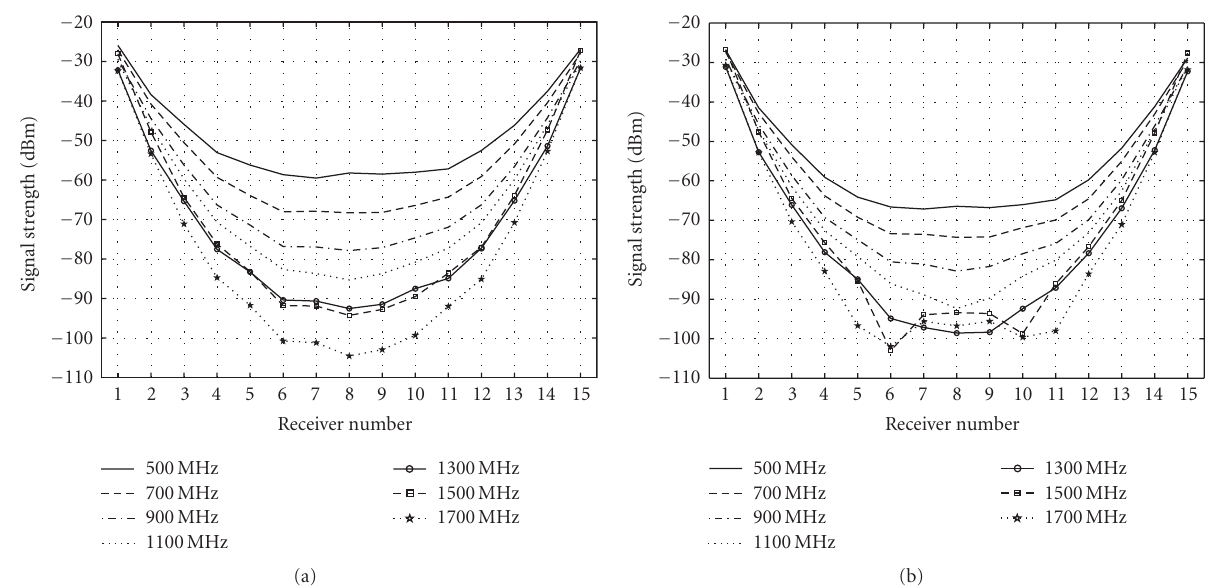
Figure 2: Signal amplitude versus relative receiver number associated with a single transmitting, 3.4 cm long antenna for a range of frequen- cies when the antenna center is submerged (a) 10 cm and (b) 2 cm below the 87% glycerin coupling liquid surface, respectively.